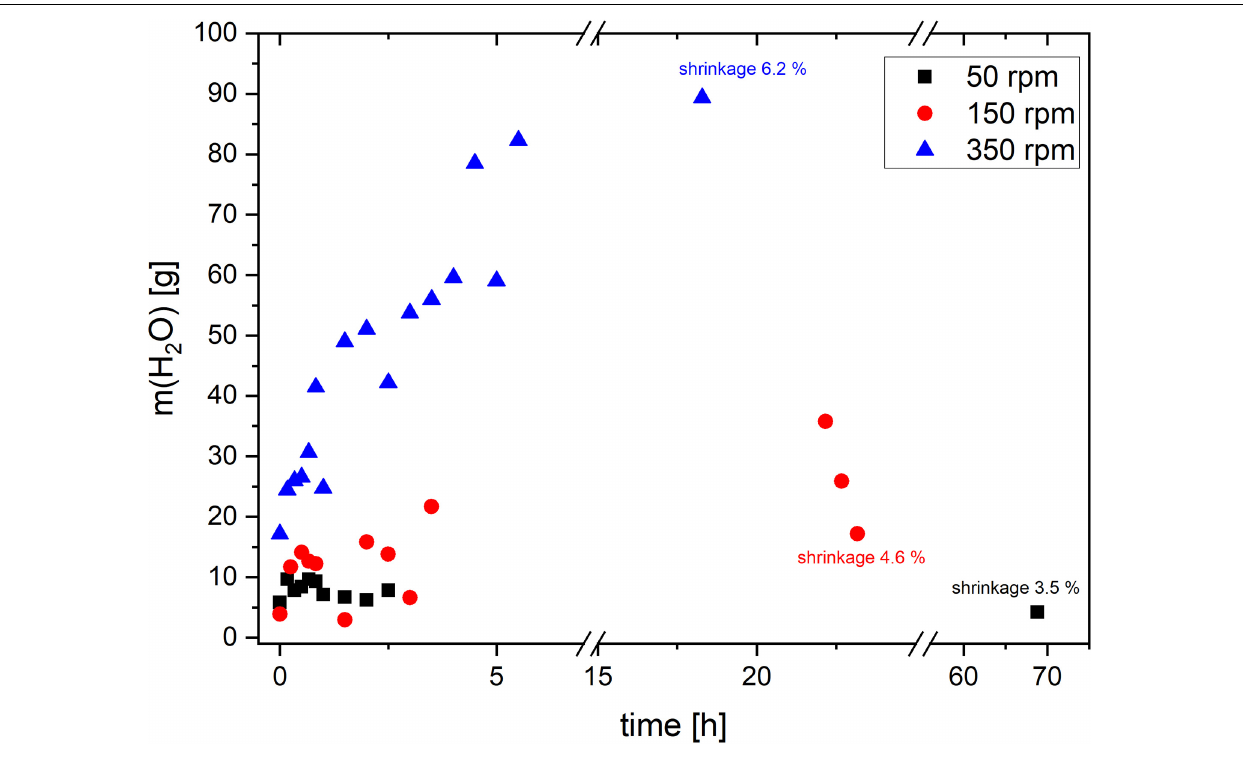
FIGURE 8 | Water content/mass in the acetone as a function of the process time at 3 different pump speeds.